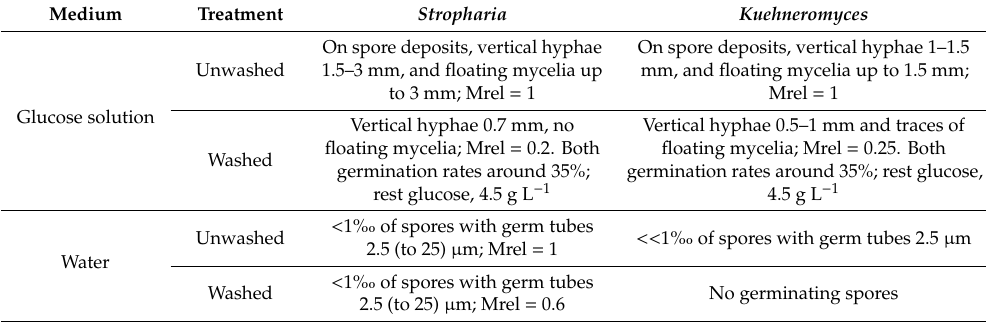
Table 4. Comparative germination of unwashed and washed basidiospores (4 g L − 1 ) in 1-mL aliquots of glucose solution (5 g L − 1 ) and bideionized water in 1-cm cuvettes at 23 ◦ C for 5 d ( n = 3–5). Mrel, visually estimated relative mycelial quantity.